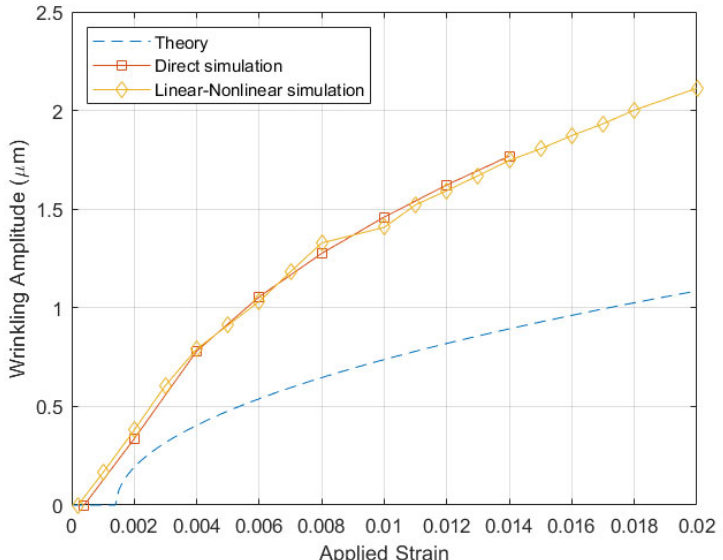
Figure 7. Wrinkling amplitude as a function of applied strain.